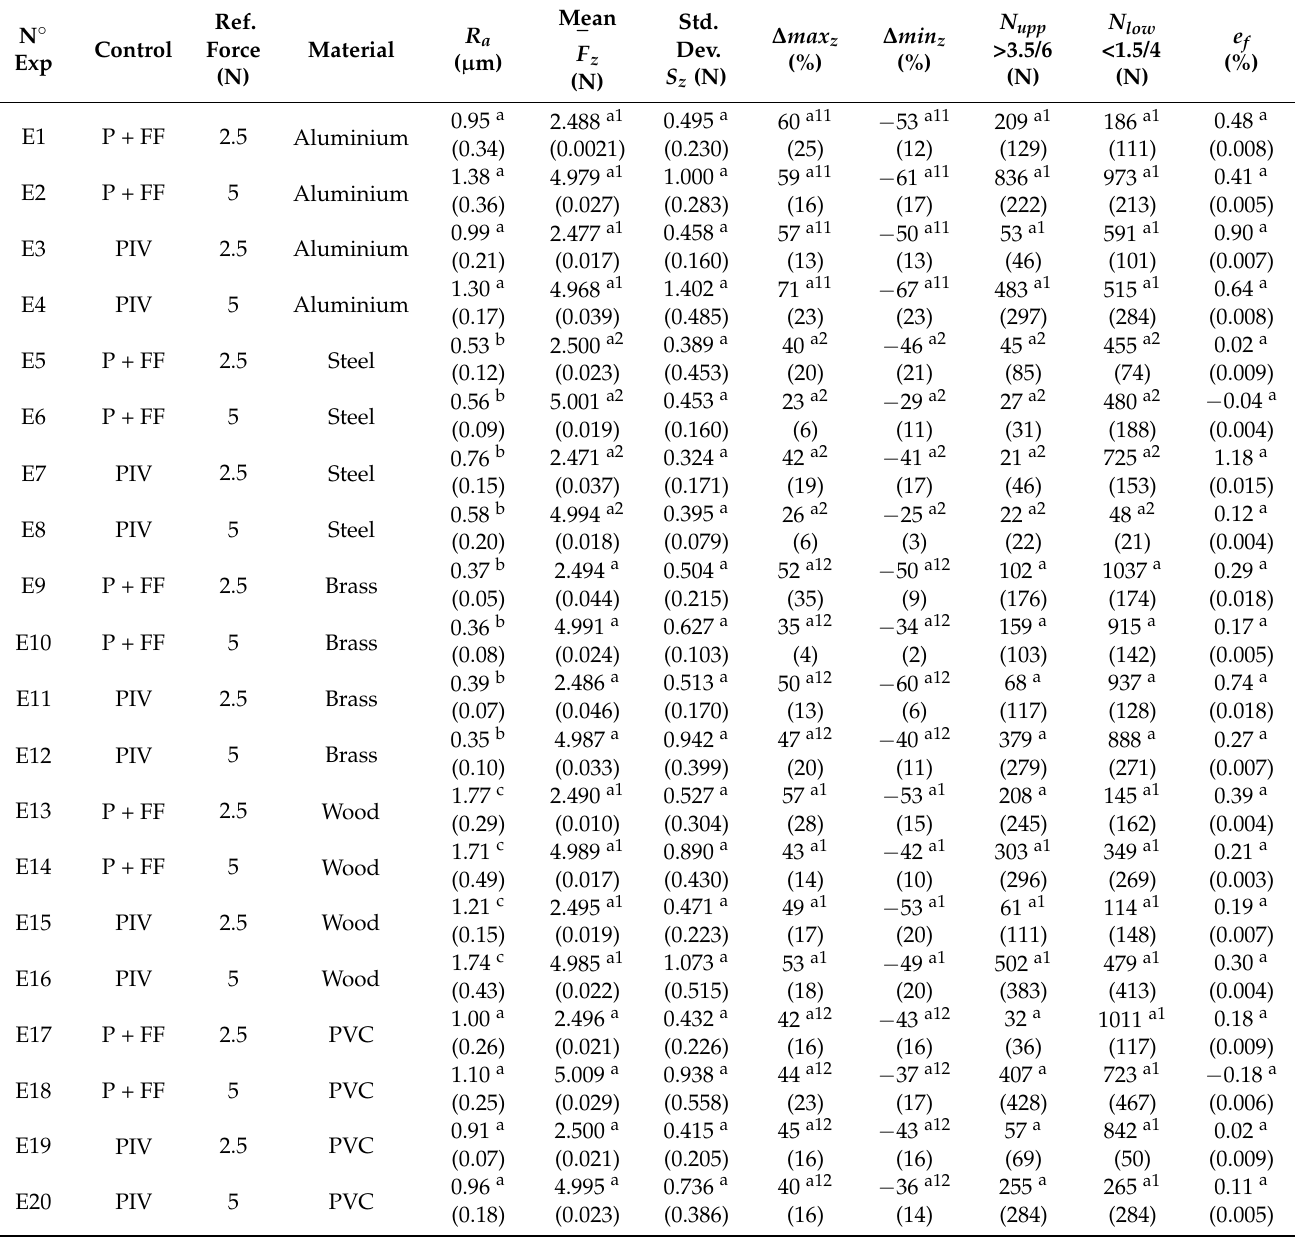
Table 2. Experimental